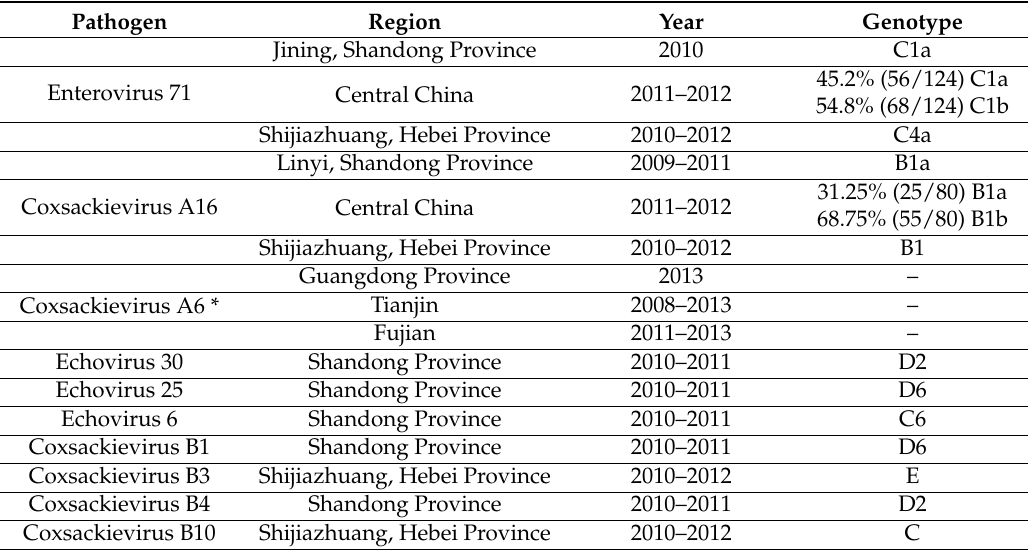
Table 1. Genotypes of different HFMD pathogens isolated in various